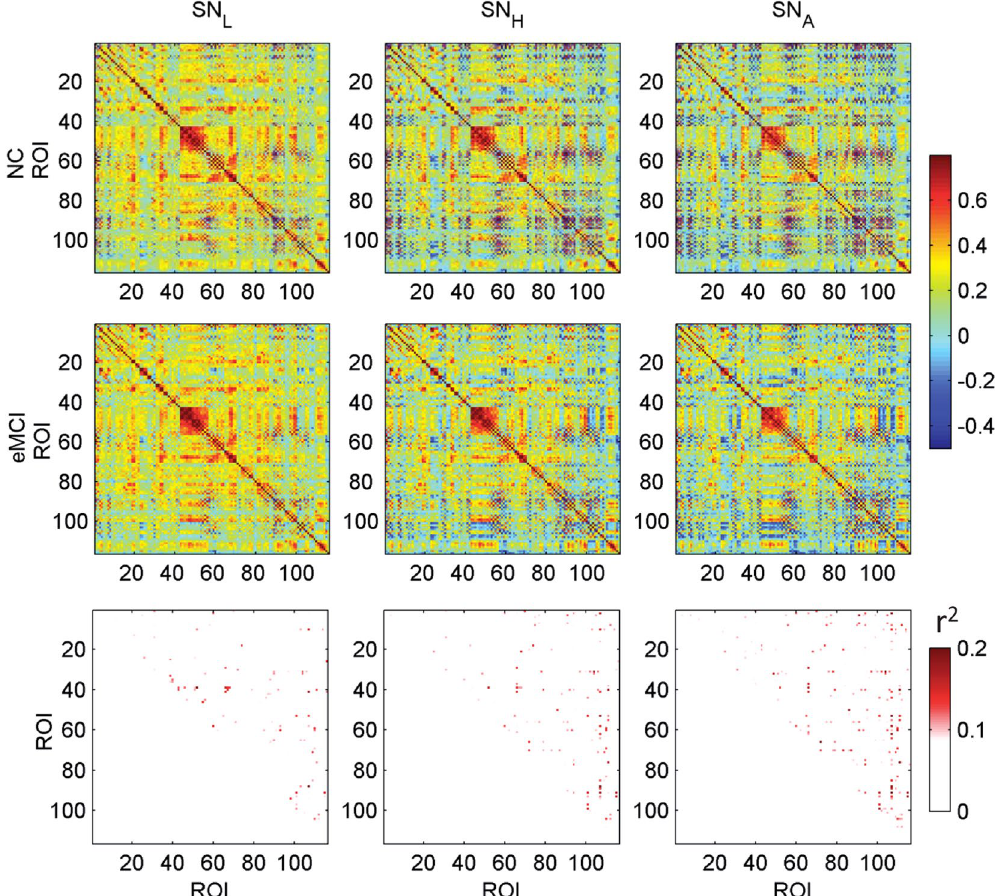
Figure 4. Group-averaged FC matrices of SN L , SN H , and SN A for NC and eMCI groups, and the separability matrices between the two groups for each type of the FC networks. The separability between the NC and eMCI subjects is calculated for each link in the network by computing r 2 value, and is color-coded from light to dark red (from less to better separability). Only the r 2 values at the upper triangle are shown since the FC matrices are symmetric. SN L : static low-order FC network; SN H : static high-order FC network; SN A : static associated high- order FC